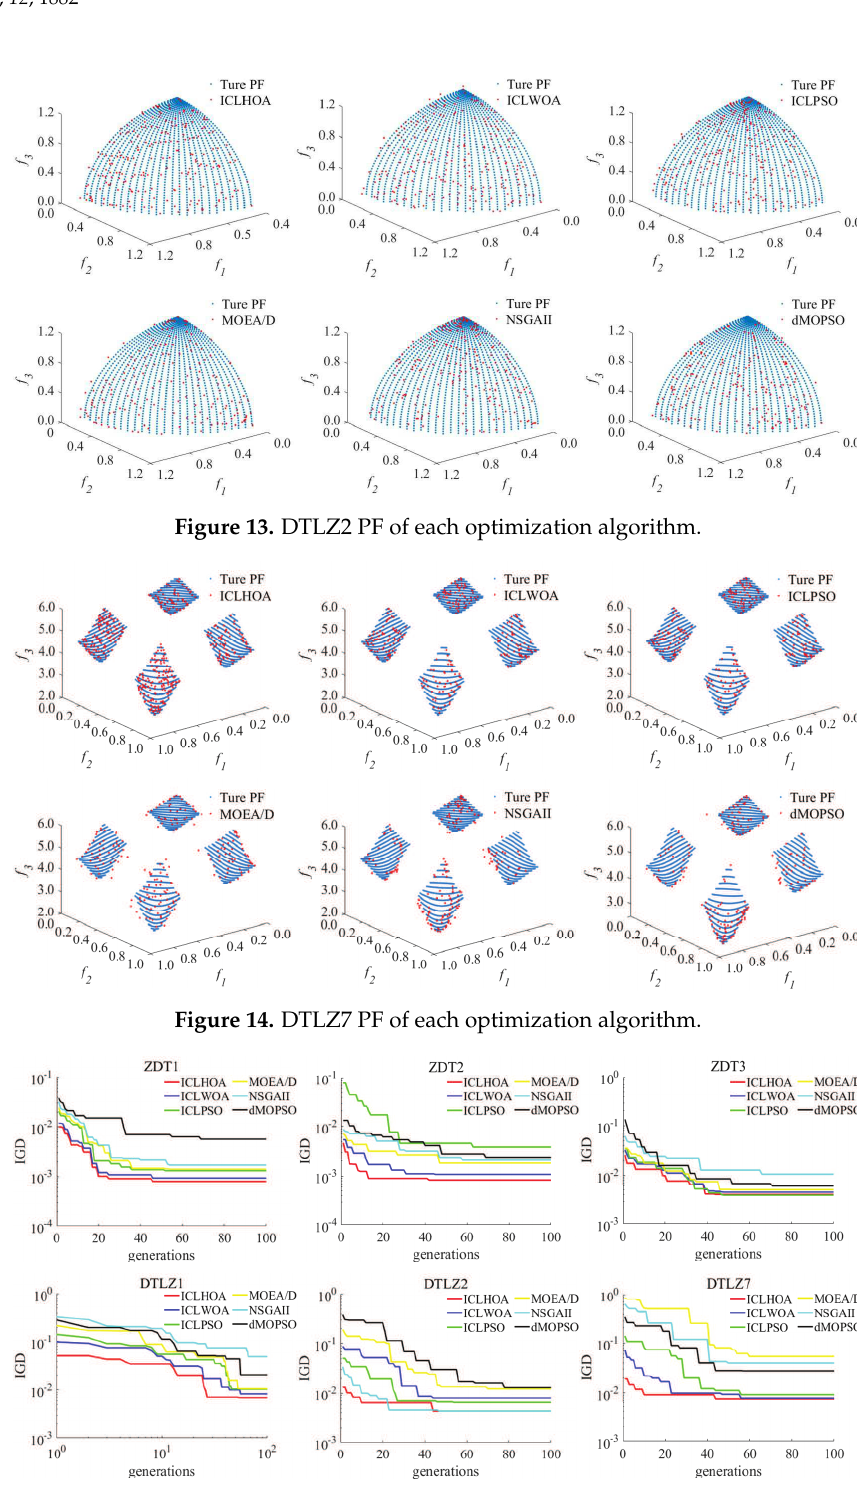
Figure 15. The iterative convergence curve of inverse generation distance (IGD) values of each optimization